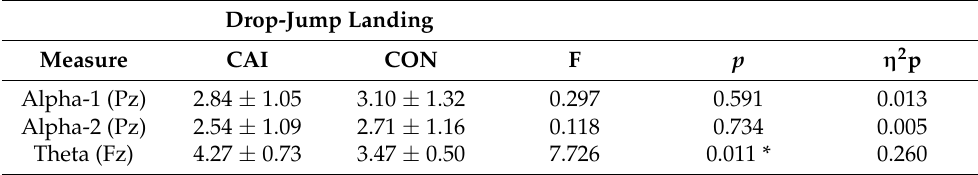
Table 2. EEG results in CAI and CON groups. Drop-Jump Landing